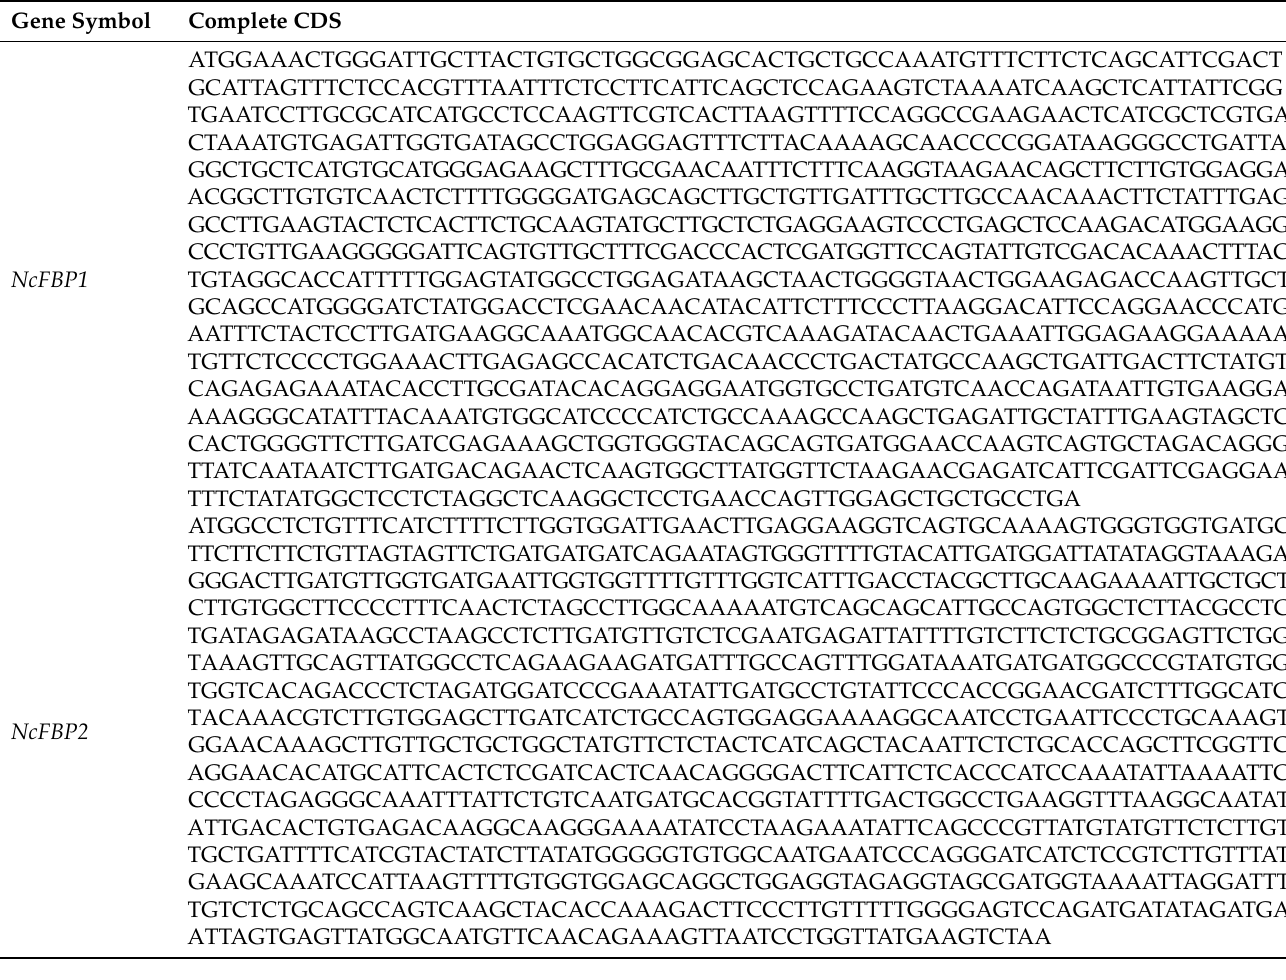
Table A1. Nucleotide arrangement information of NcFBPs